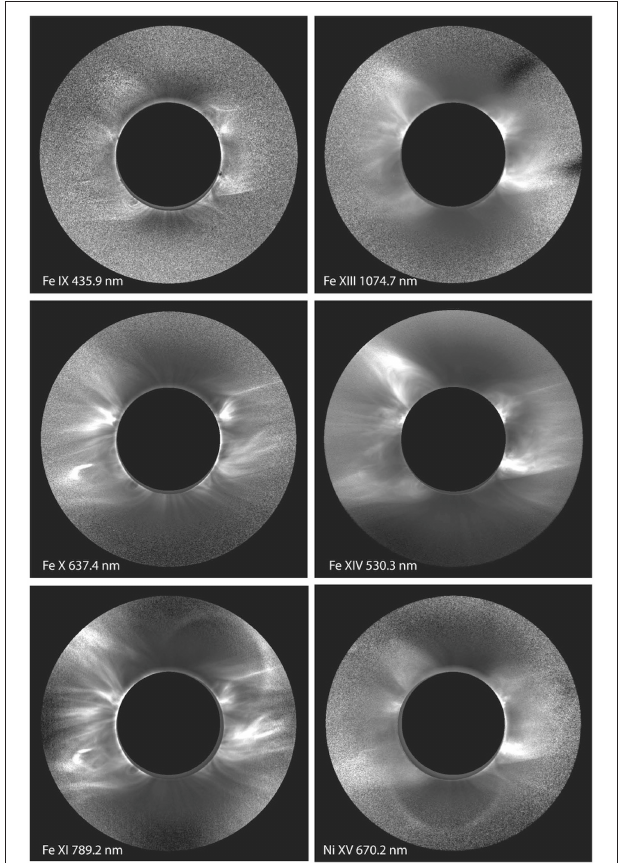
FIGURE 1 | The solar corona from the solar limb to about 2.5 R ⊙ from disk center observed during the 2010 South Pacific total eclipse (Habbal et al., 2011) in six coronal emission lines with temperature ranging from 0.8 to 2.0 MK. Images are courtesy of S.